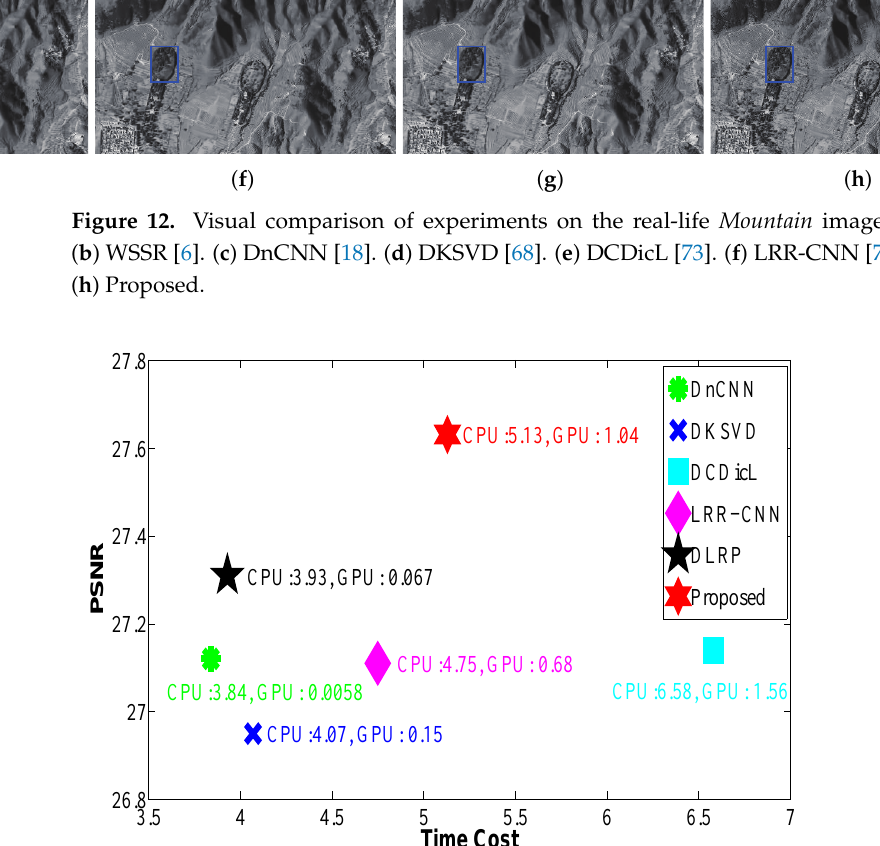
Figure 13. Computational time vs. PSNR for different approaches on the MODIS-A1 image with size 512 × 512; the noise level is